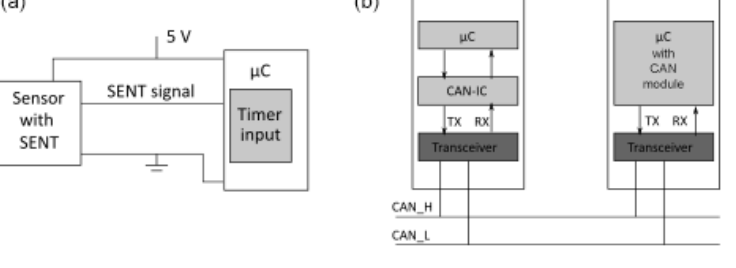
Figure 1. SENT (a) and CAN schematics (b) .